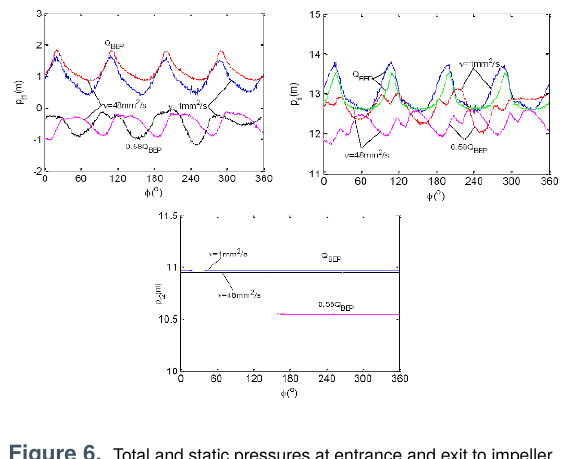
Figure 6. Total and static pressures at entrance and exit to impeller aswellaspumpoutletasafunctionimpellerrotatingangle at both beast efficiency and part-loading points.